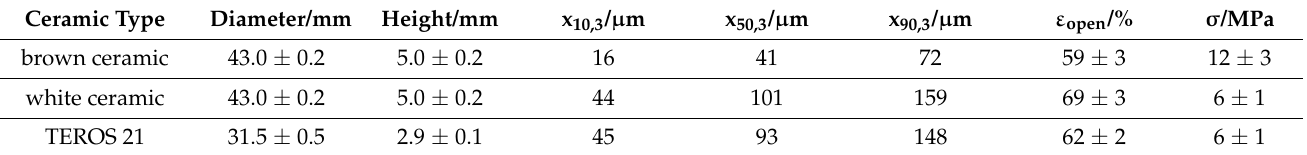
Table 2. Data of ceramic characterization of brown and white kieselguhr and TEROS 21 ceramic. Ceramic Type